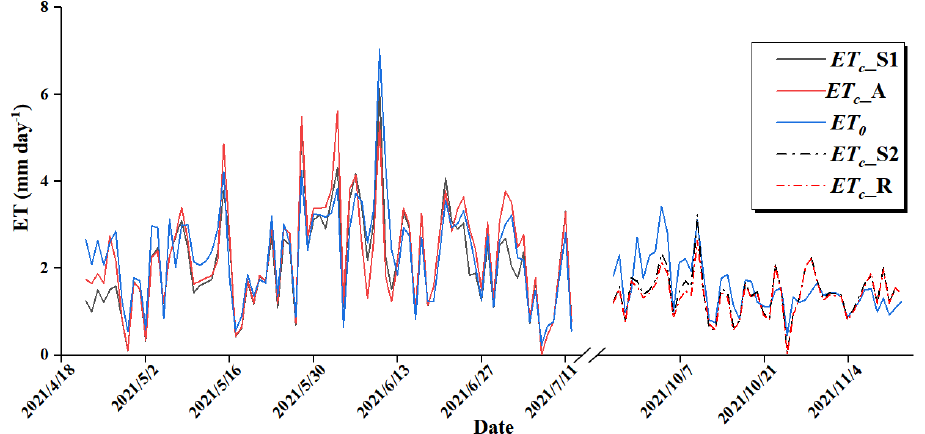
Figure 9. Time evolution of the reference ET ( ET 0 ) and daily ET c of different treatments during crop growth period in two growing